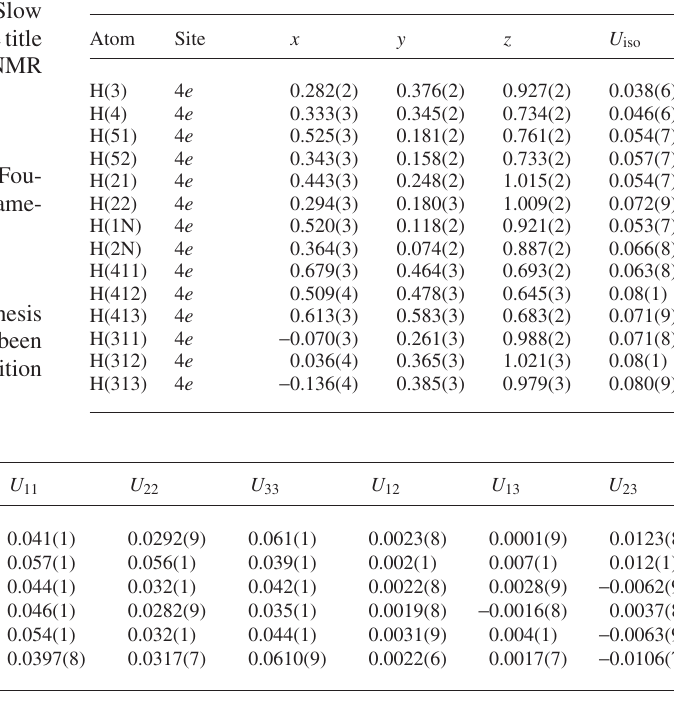
Table 2. Atomic coordinates and displacement parameters (in Å 2 ) .